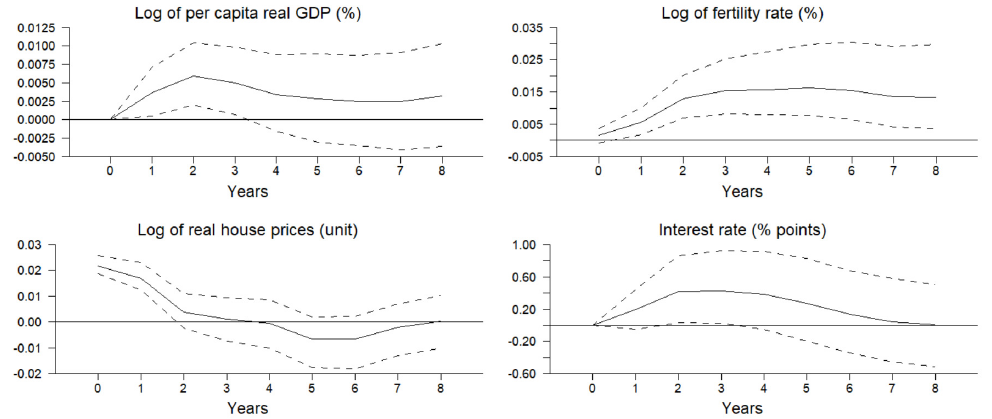
Figure 12. Responses to a house price shock in the baseline SVAR when the fertility rate is ordered last; additionally, the ordering of the interest rate and house prices are interchanged in the model.